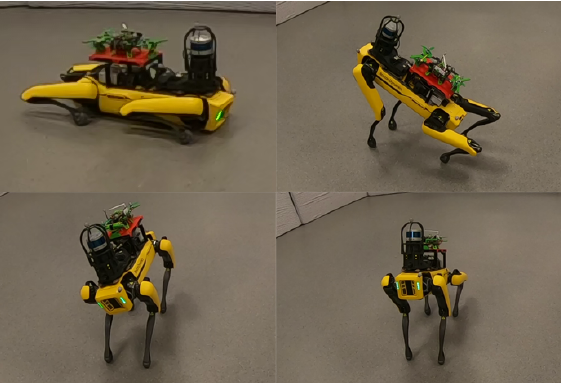
Figure 11. The Spot robot carrying the R-shafter drone in different poses.